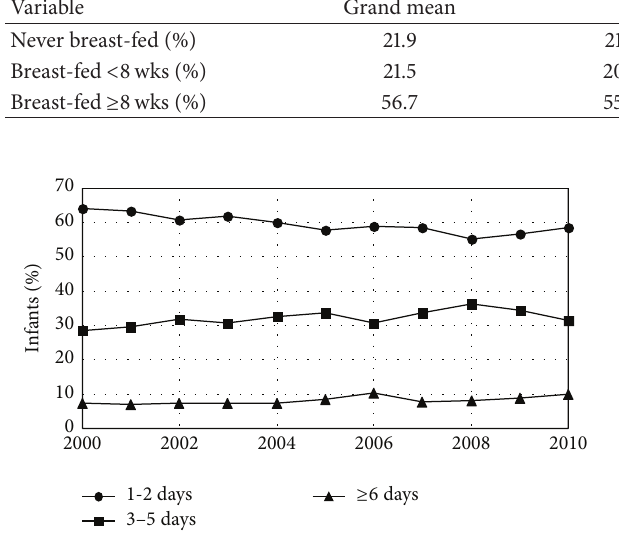
Figure 7: Birth weights for infants born in Maine by year. The fraction of infants who weighed ≥ 4000 gms at birth declined over time. Healthy People 2020 has the objective of a reduction in low birth weight births to 7.8% of total births. Maine currently meets this